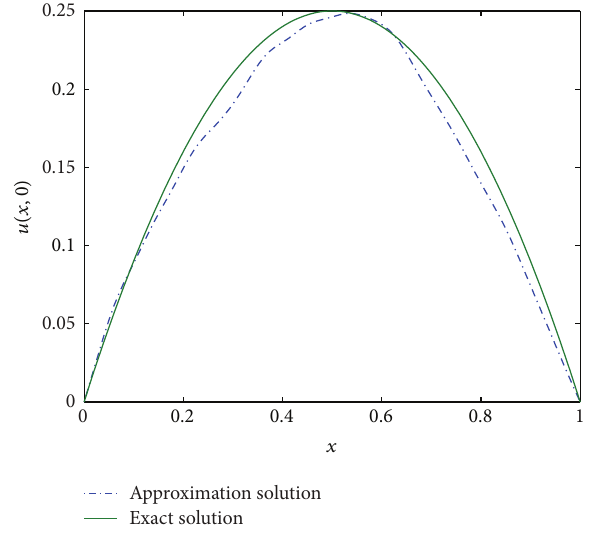
Figure 3: Exact solution 𝑢(𝑥,0) and numerical solution for 𝜖 = 20 % with the final time 𝑇 = 25 and 𝑚 = 59 , 𝑁 = 59 , and 𝑡 0 = 1𝑒 − 10